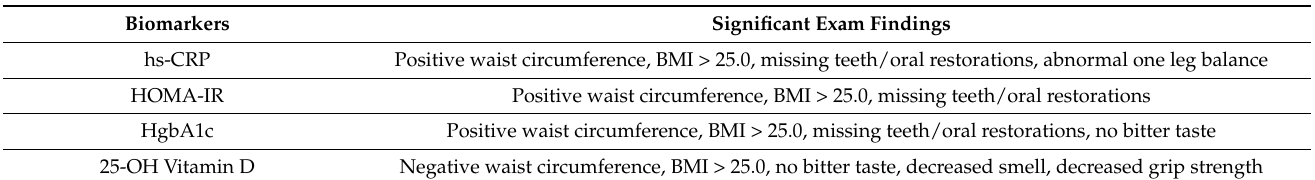
Table 6. Statistically Significant Associations ( p ≤ 0.05) between Biomarkers and Physical Exam/ Anthropometric